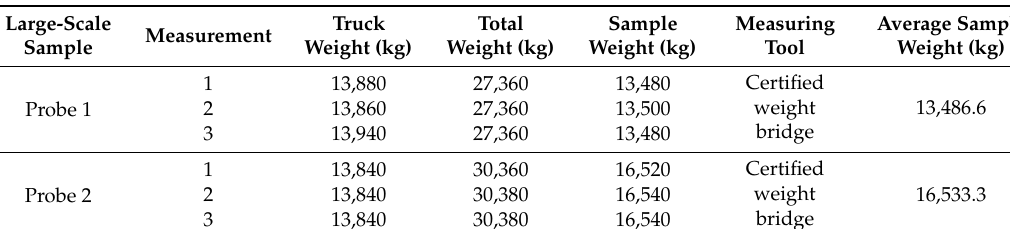
Table 2. Calculation of average weights of large-scale samples Probe 1 and Probe 2 from measurements on a certified weight bridge (3 weightings of each probe).